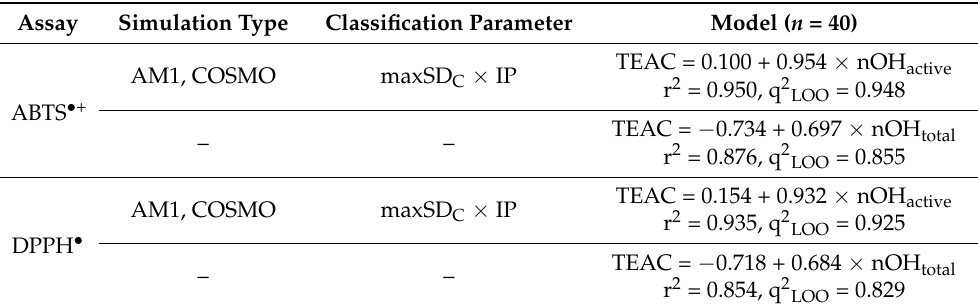
Table 4. Models with the highest internal predictive ability obtained for ABTS ● + and DPPH ● assays using chromans subgroup of compounds, compared to those obtained without OH-group classification. For q 2 LOO calculations, all thresholds were recalculated for each LOO model.